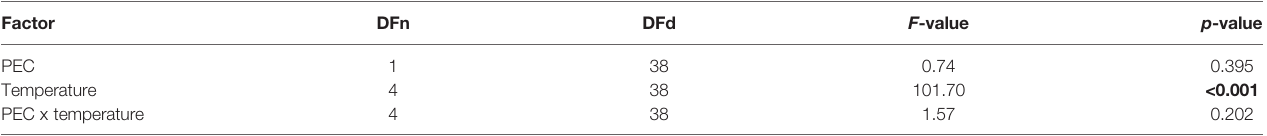
TABLE 6 | Two-way ANOVA to investigates effects of pre-experimental cultivation (PEC) and experimental temperature on optimum quantum yield F v /F m of juvenile Laminaria digitata sporophytes after 2 weeks in a temperature gradient following PEC of parental gametophytes.